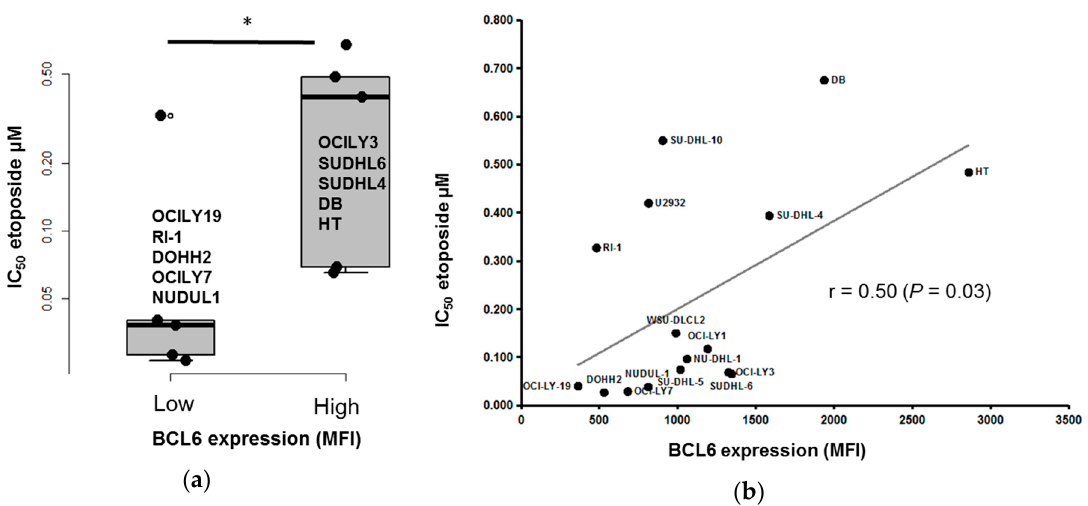
Figure 6. BCL6 expression correlates with the response to etoposide in DLBCL cell lines. Box-plots illustrate the inhibitory concentration 50 (IC 50 ) of etoposide on a logarithmic scale. The boxes represent the 25th and 75th percentile values. The line in the middle corresponds to the median. The vertical lines correspond to the 10th and the 90th percentiles, and the circles, to the outliers. * p value < 0.05 (Mann-Whitney U-test) ( a ). Linear regression analysis of BCL6 expression (MFI) in function of the IC 50 of etoposide in 16 DLBCL cell lines. r represents the Spearman correlation coefficient, p value < 0.05 (Spearman correlation test) ( b ).